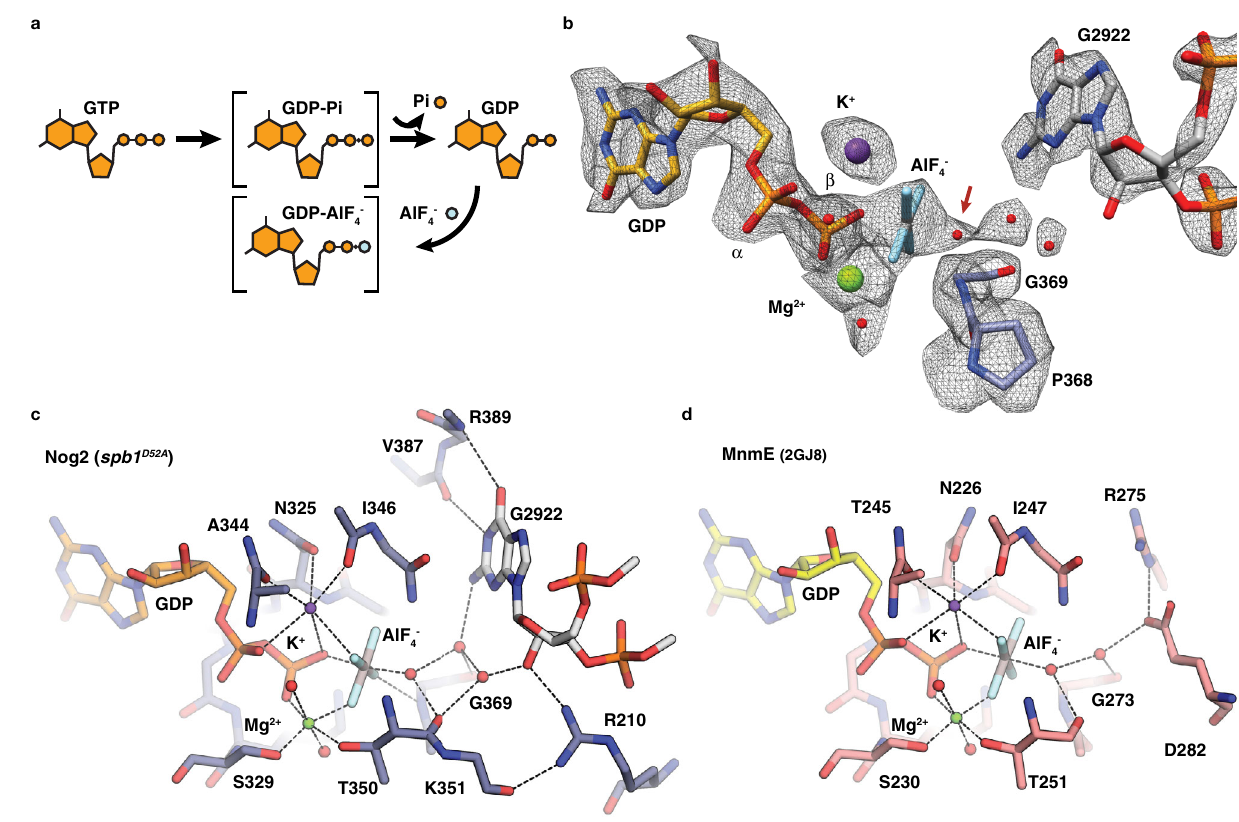
Fig. 2 | G2922 isdirectlyinvolved inNog2 GTPase activation. a Schematic of the transition state trapping strategy. AlF 4 - was added back to Nog2 pre intermediates puri fi ed from the spb1D52A strain to mimic the transition state of GTP hydrolysis. b Map density in the active site of Nog2 after AlF 4 - addition, showing extra density consistent with the presence of tetragonal AlF 4 - and unmethylated G2922. c Active site coordination in the reconstituted transition state structure showing the orga- nized water triad. Nog2 residues participating in the coordination network are